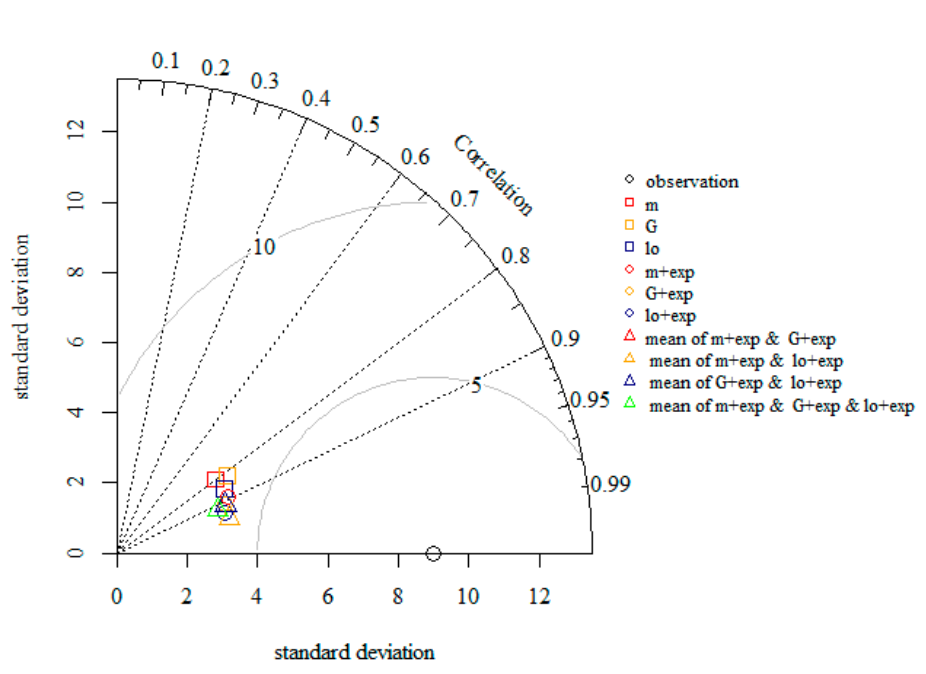
Figure 3. A Taylor diagram illustrating the statistics of the comparison between the observed and model estimates of the beginning of oilseed rape maturation in 2012–2016.